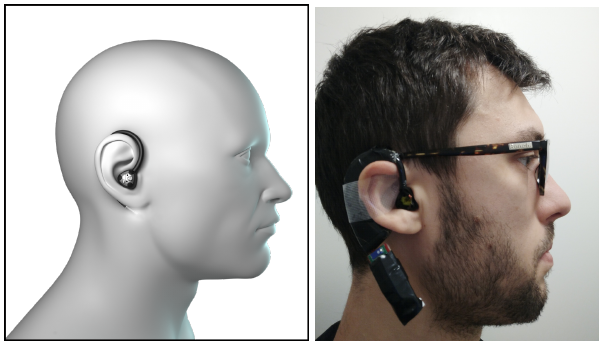
Figure 1. Digital earpiece prototype.